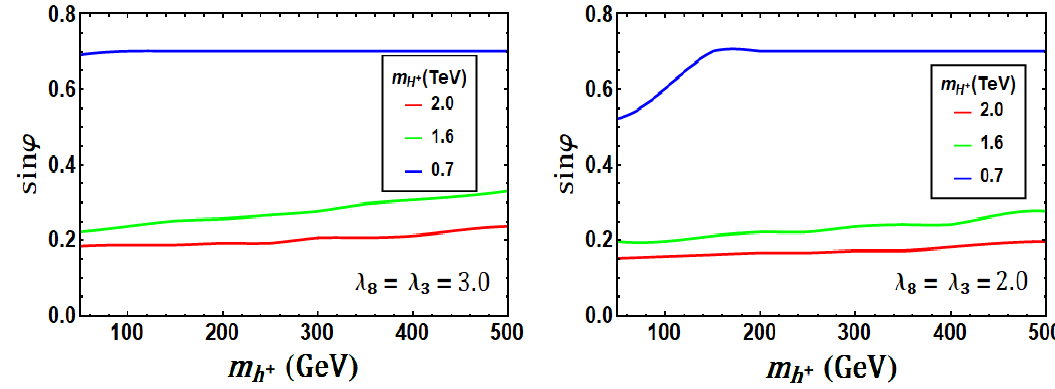
Figure 5 . Maximum allowed value of the mixing parameter sin ’ from charge-breaking minima constraints as a function of the light charged Higgs mass m , for di(cid:11)erent values of the heavy h + charged Higgs mass m = 2 TeV, 1.6 TeV and 0.7 TeV, shown by red, green and blue curves, H + respectively. We set the quartic couplings (cid:21) 3 = (cid:21) 8 = 3 : 0 (left) and (cid:21) 3 = (cid:21) 8 = 2 : 0 (right), and vary (cid:21) 2 ; (cid:21) (cid:17) in the range [0.0, 3.0]. For a given m , the region above the corresponding curve leads to H + charge-breaking